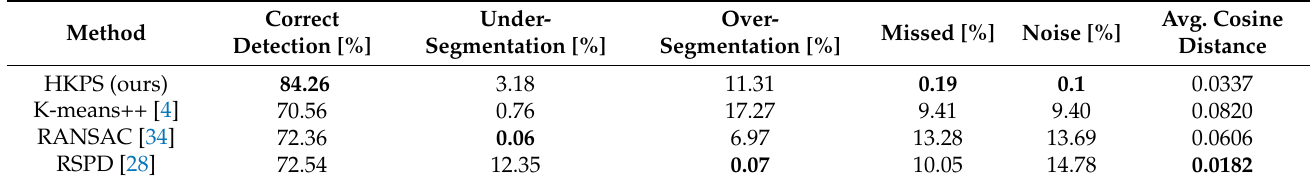
Table 1. Average result of without-noise Virtual KITTI Dataset. Best results are highlighted in bold.